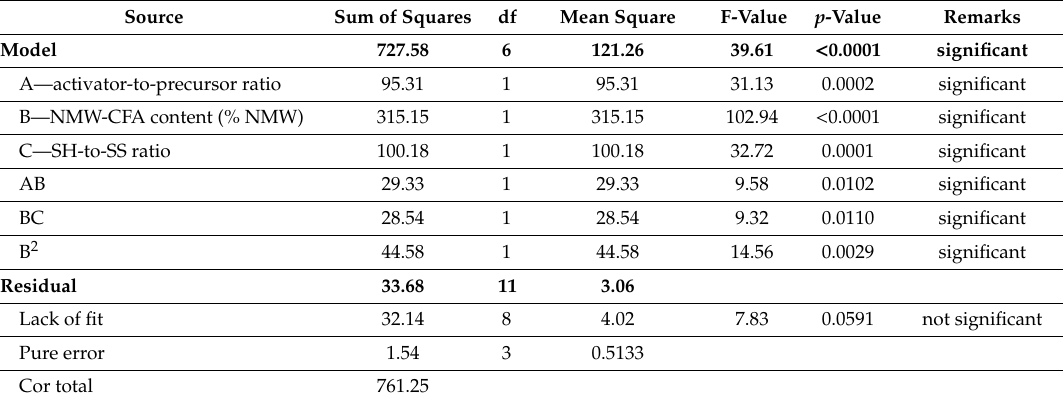
Table 8. ANOVA for the reduced quadratic